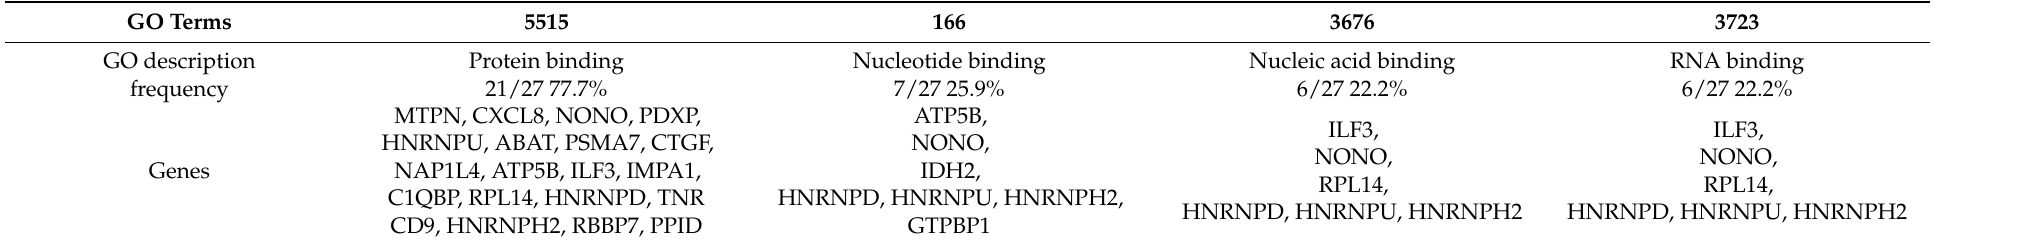
Table 3. Gene Ontology analysis, molecular